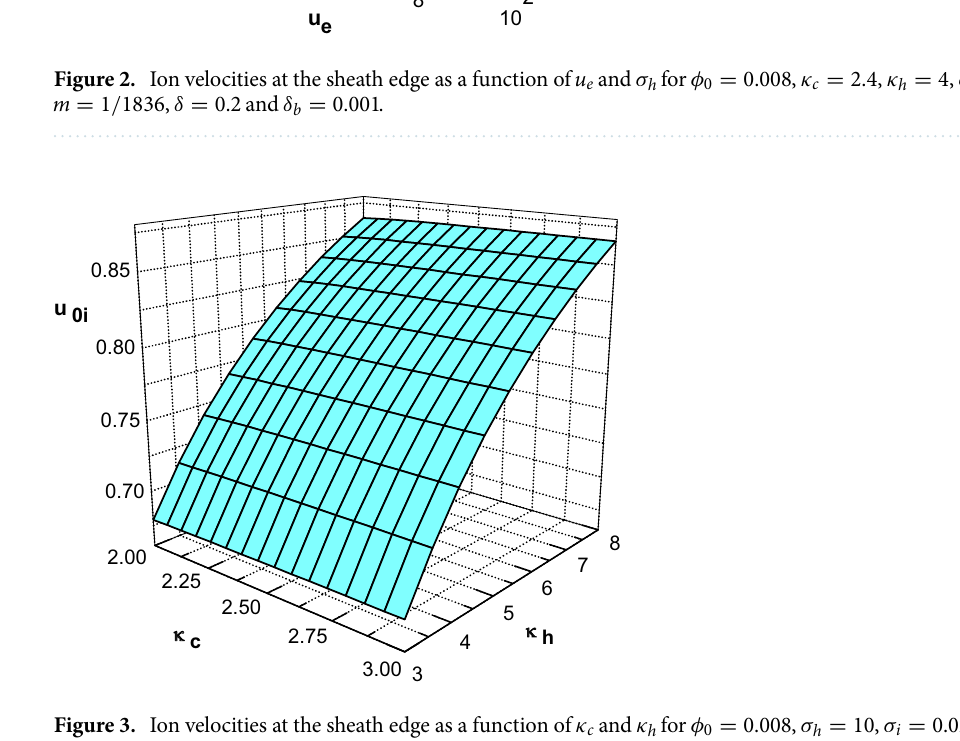
Figure 3. Ion velocities at the sheath edge as a function of κ c and κ h for φ 0 = 0.008 , σ h = 10 , σ i = 0.02 , m = 1 / 1836 , δ = 0.2 and δ b = 0.001